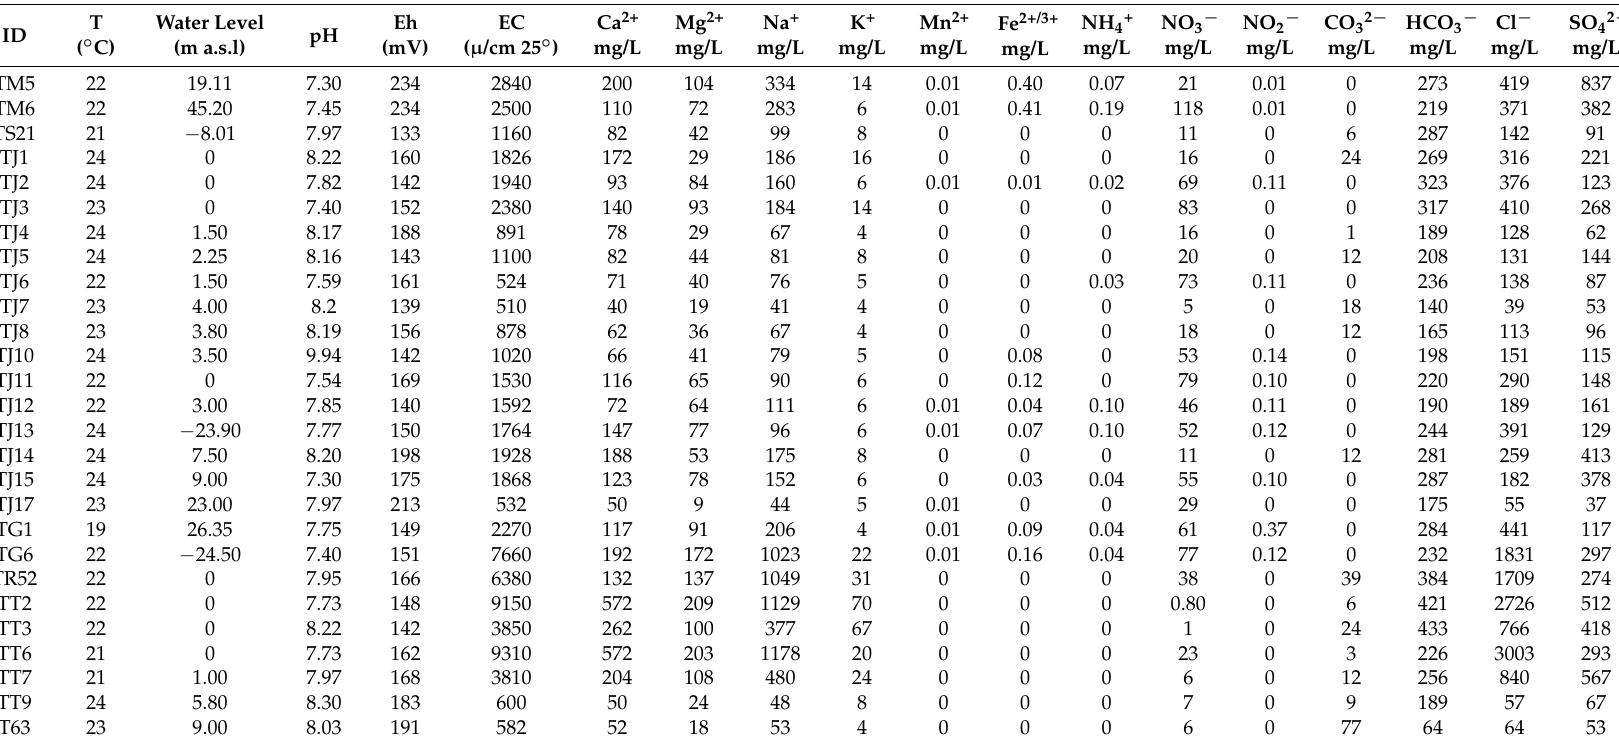
Table 6. Analytical results for physico-chemical parameters of selected groundwater samples in